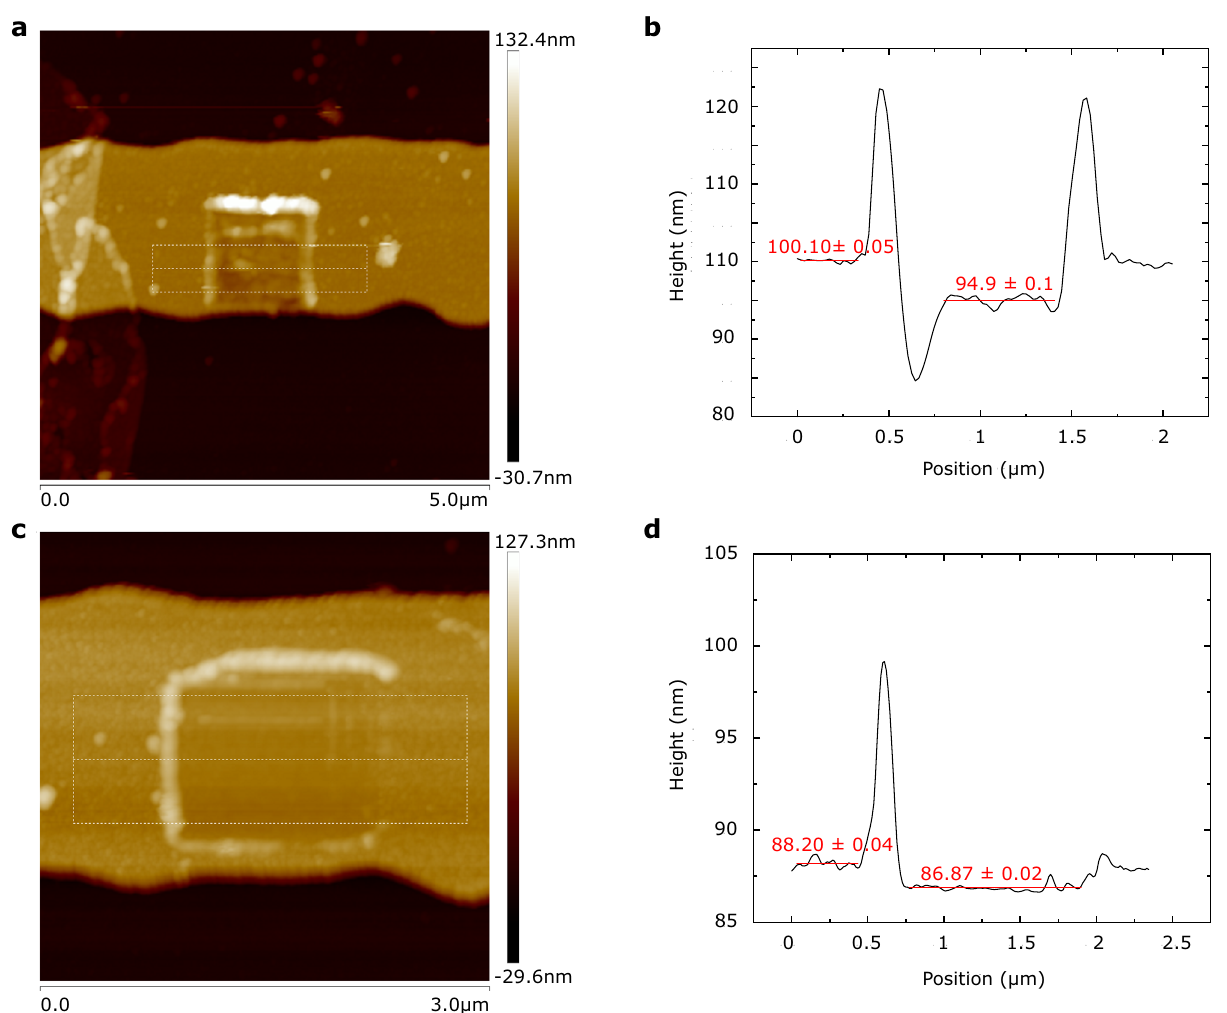
Fig. 6 AFM imaging of device regions verifying the formation of a QD monolayer. a – b Height pro fi le across an Au electrode where the QD SAM is fi rst assembled and subsequently scraped away mechanically using an AFM tip. Measured height difference~5.2nm. c – d Height pro fi le across an Au electrode where the QD SAM is not assembled, due to photoresist protection, but with the area still scraped mechanically with the AFM tip. Measured height